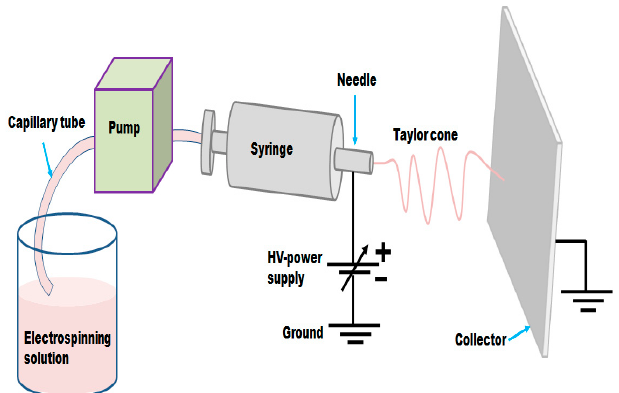
Figure 1. Graphical configuration illustrates the home made electrospinning technique applied for the synthesis of C/NiCo 2 O 4 hybrid nanofibers. The mixed precursors were loaded into a plastic syringe using through a simple pumping system. When a high voltage of 15 kV was applied, the electrospinning solution moves forming a very thin mat of fibers on aluminum foil which surrounded the rectangular